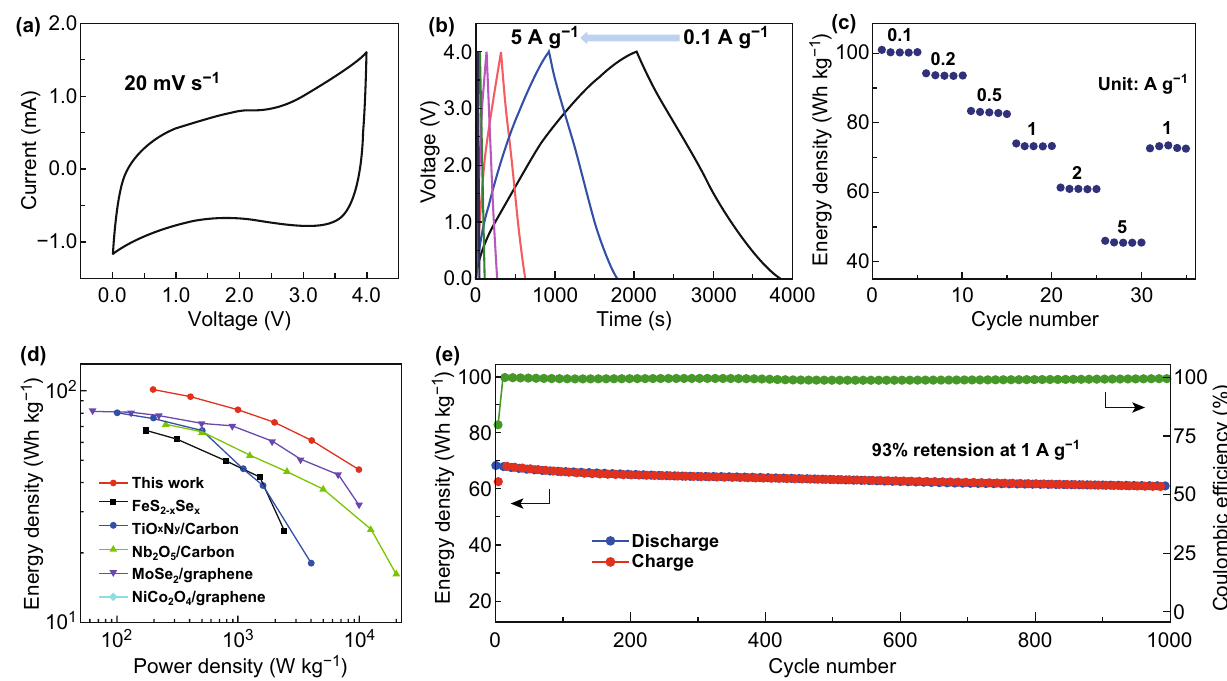
Fig. 6 Electrochemical performance of the Co 9 S 8 @NC-9//CG NIC cells. a The CV curves of the Co 9 S 8 @NC-9//CG NIC full cell. b Galvano- static charge–discharge profiles and c rate performance at various current densities from 0.1 to 5 A g −1 . d Ragone plots of the Co 9 S 8 @NC-9//CG NIC cell and the comparison with other reported NIC systems. e Cycling performance of a Co 9 S 8 @NC-9//CG NIC at a rate of 1 A g